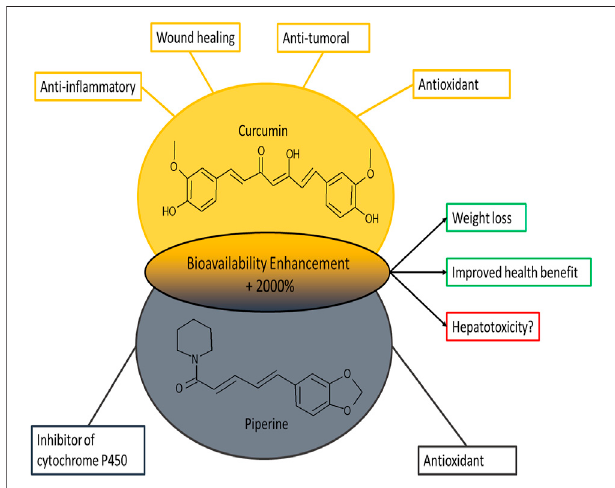
FIGURE 1 | Representation of the chemical structures of curcumin and piperine and their main biological effects.